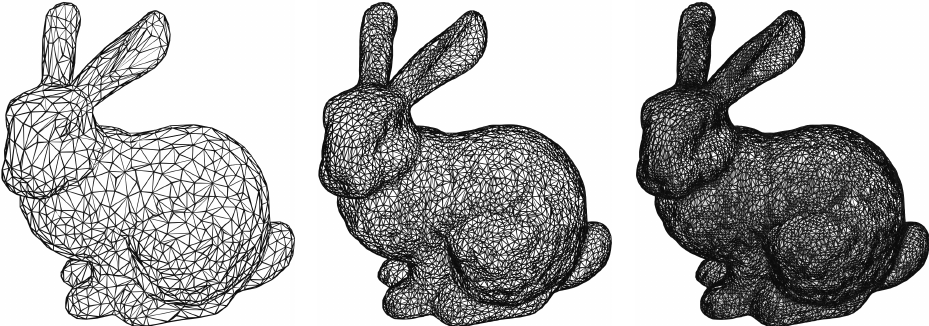
Figure 1. Different approximations of the “Stanford Bunny” using triangular